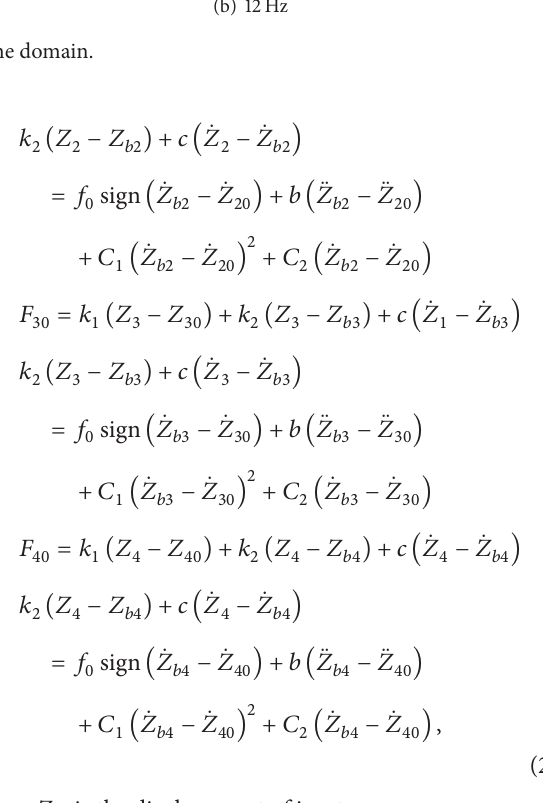
Figure 6: Force in time domain.